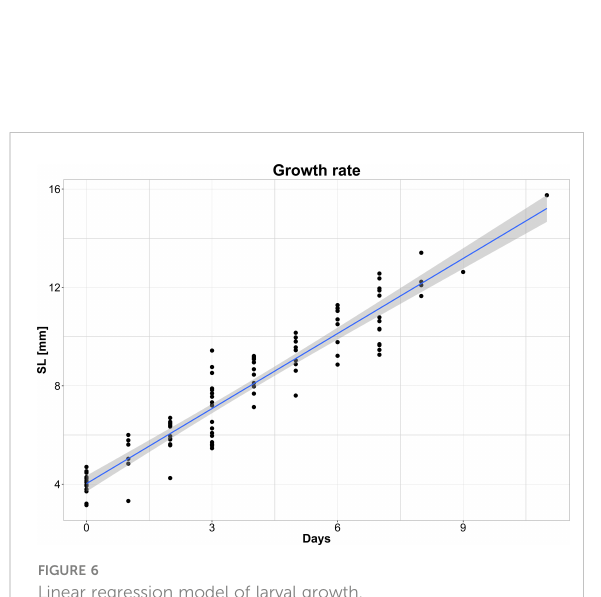
FIGURE 6 Linear regression model of larval growth.